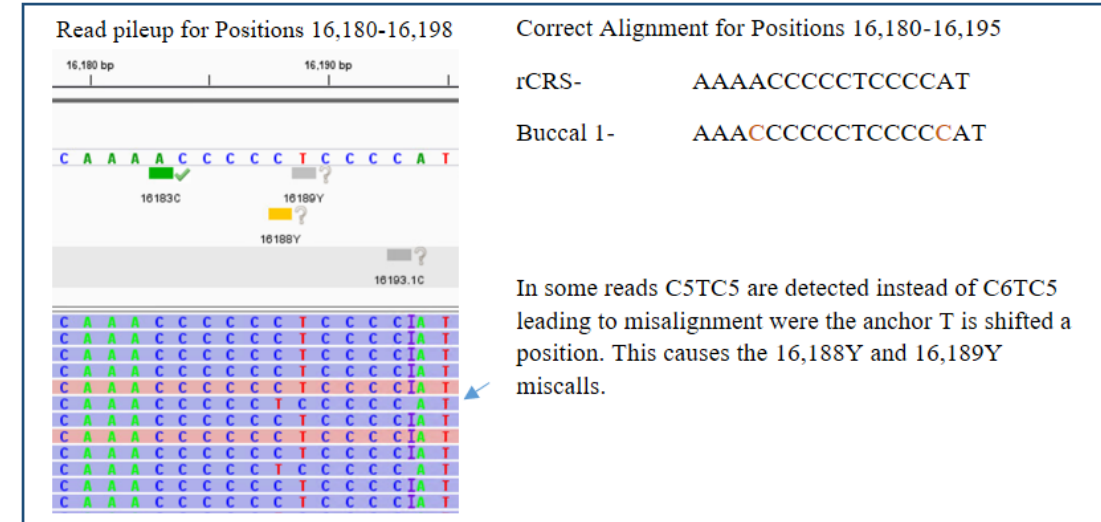
Figure 5. Precision ID homopolymer detection causing an alignment miscall at positions 16,188 and 16189. The insertion at position 16,193 is represented as a purple i.